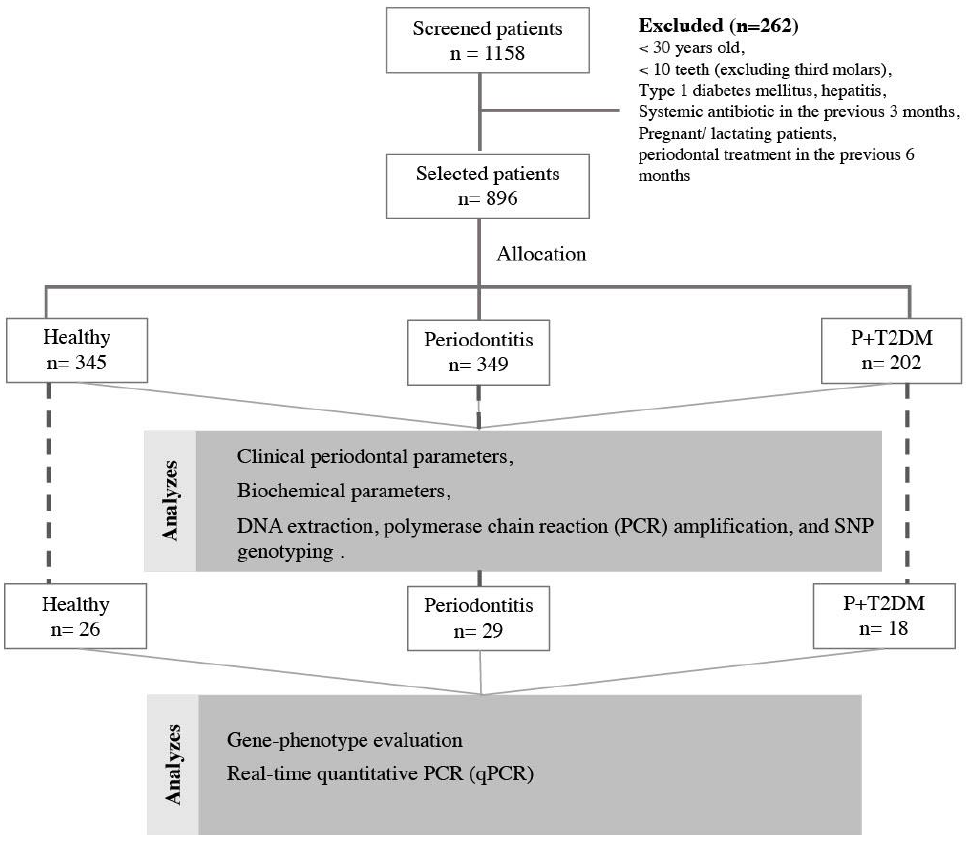
Figure 2. Flowchart of the study.